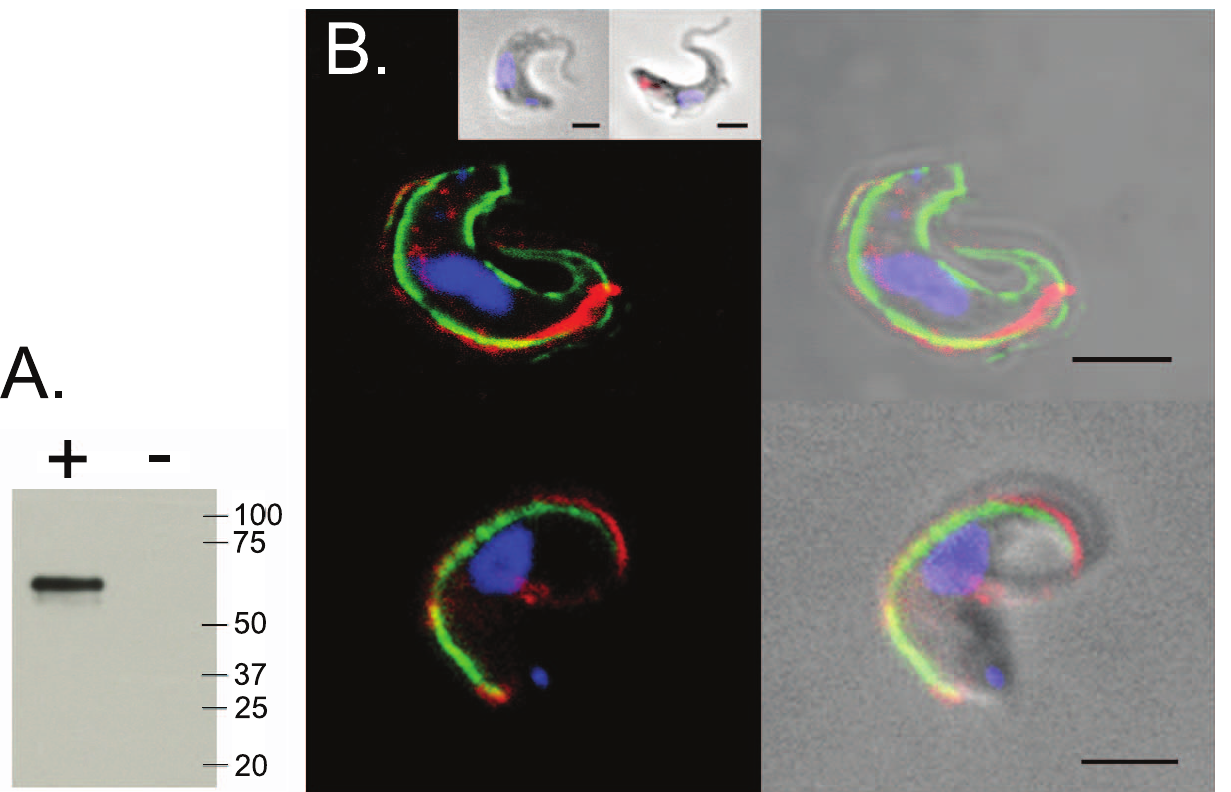
Figure 4. Expression of a Fam50 gene (Tb927.7.380) in T.brucei . A . Western blot; 2 6 10 7 cells were sampled from either induced ( + ) or uninduced ( 2 ) cells after 1-day induction with 1 m g/mL tetracycline. Markers shown in kDa. B . Immunofluorescence analysis of Tb927.7.380 expression in T. brucei , showing co-staining of non-permeabilised cells with plasma membrane protein VSG 221 ( top ) and PFR2 ( bottom ). Left : Merged images with color combination for DAPI-stain of the nucleus and kinetoplast (blue), fluorescent stain of HA epitope tag (red) and VSG/PFR fluorescence (green). Right : merged pictures from phase and fluorescence. Inset : co-staining of non-permeabilised and permeabilised cells with Rab11 (intracellular marker). No fluorescence was seen from non-transfected cells (data not shown). GFP expressed from pDEX-577 vector localised to the cytoplasm (data not shown). Scale bar is 2 m m.